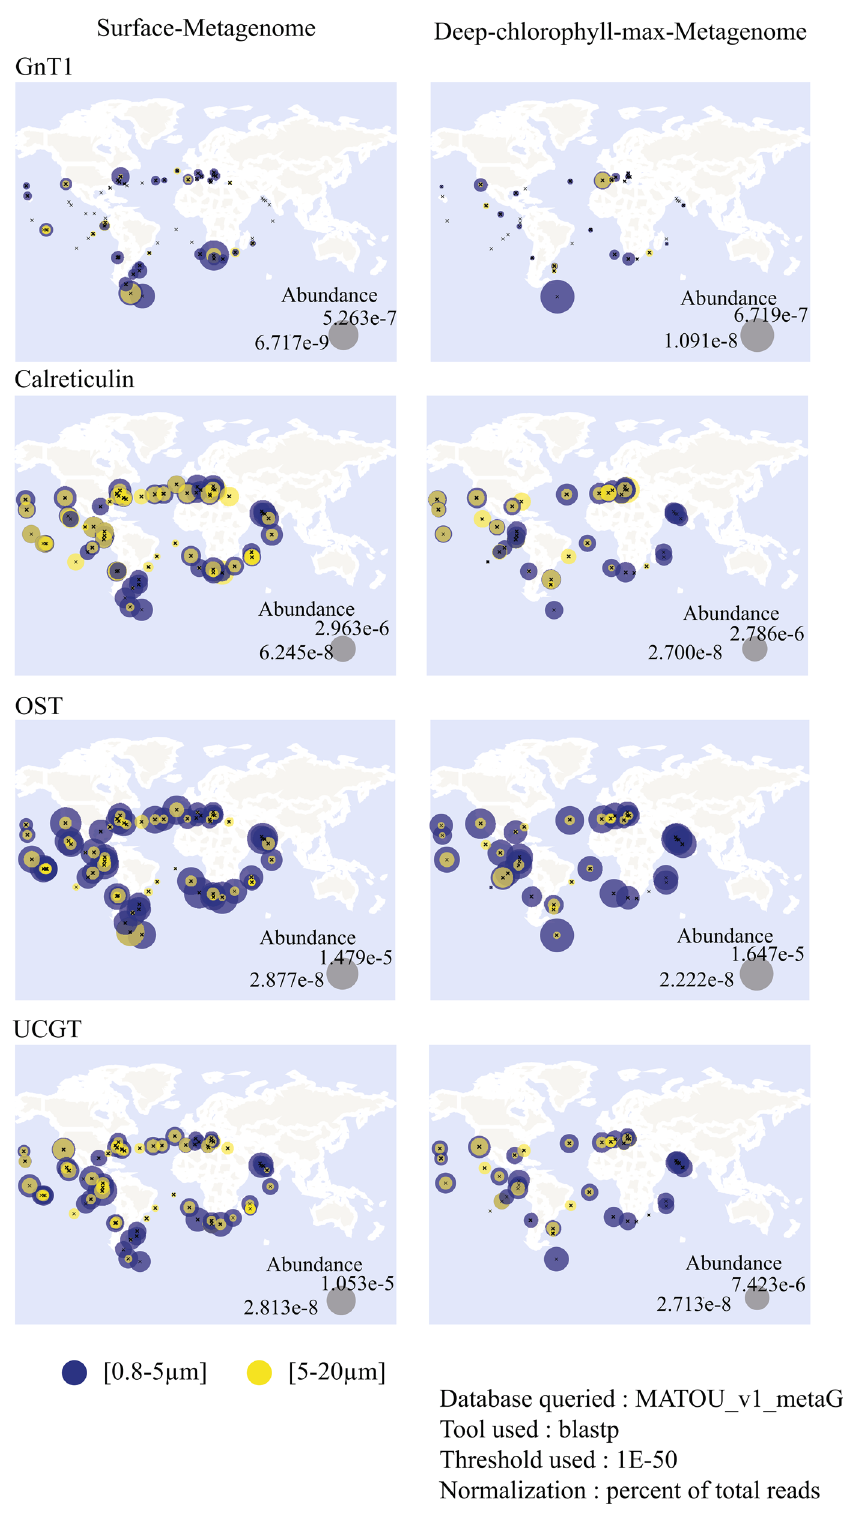
Figure 5. Global distribution of members of the N-linked glycosylation pathway. The global distribution of calreticulin, oligosaccharyltransferase (OST), UDP-glucose glucosyltransferase (UGGT), and N-acetylglucosaminyltransferase (GnT1) was analyzed using a blastp (e-value threshold of 1E-50) search in the Tara Oceans Metagenome database 53 . The presented maps were downloaded from http://tara-ocean s.mio.osupy theas .fr/ocean -gene-atlas /. Two size fractions are shown, 0.8–5 µm (blue) and 5–20 µm (yellow). The size of the circle represents the percentage of total reads. The left panel shows surface samples, and the right panel shows deep-chlorophyll max